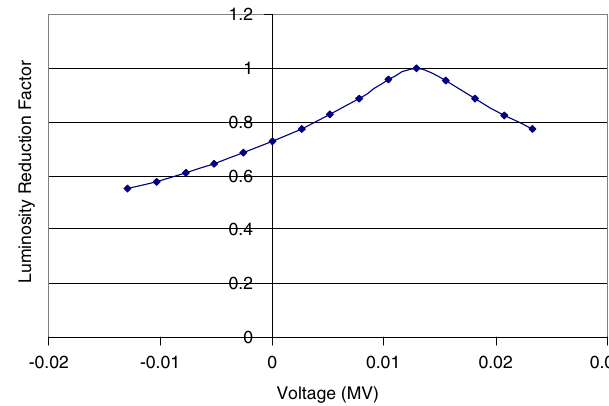
FIG. 6. (Color) Luminosity reduction factor for various roll misalignments of the ILC crab cavities as a function of bunch charge.